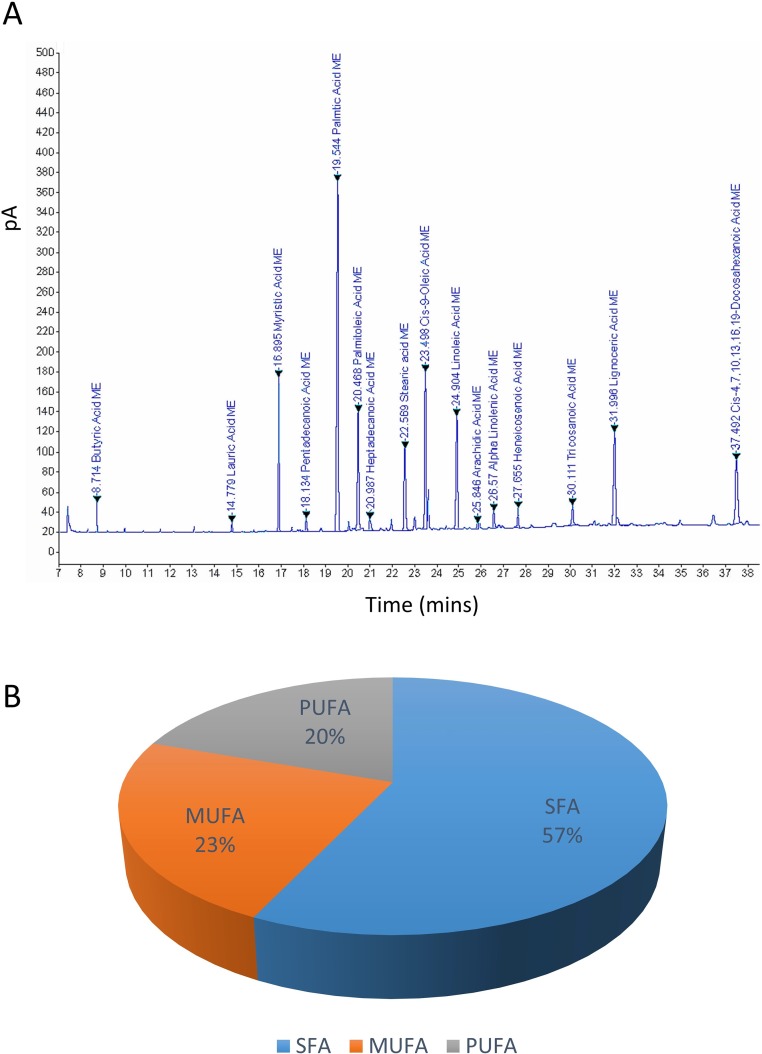
Gas chromatography–flame ionized detector (GC–FID) chromatogram of sea buckthorn oil (SBKT). (A) The fatty acid composition of the SBKT was determined using the GC–FID methodology. Individual fatty acids were identified and quantified using fatty acid methyl ester methodology. Chromatography analysis identified 16 major fatty acids. (B) Pie-diagram represents the percentage of three categories of fatty acids identified in the SBKT—saturated fatty acids (SFA), monounsaturated fatty acids (MUFA), and polyunsaturated fatty acids (PUFA) (also see
Table 1
).